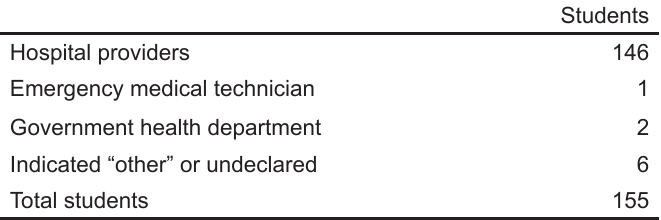
Table 1. Description of simulation student participants by self- declared job